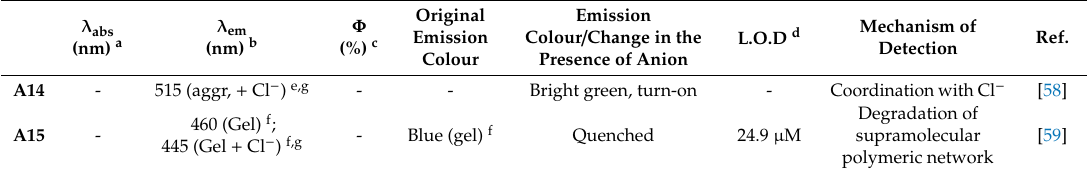
Table 2. Summary of optical properties and sensing performance of AIE-based chloride chemosensors A14 – A15